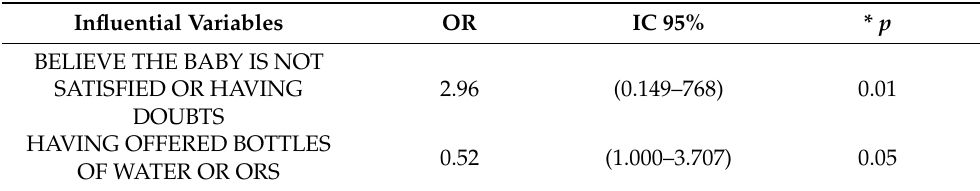
Table 3. Conditions influencing the cessation of exclusive breastfeeding at 6 months.